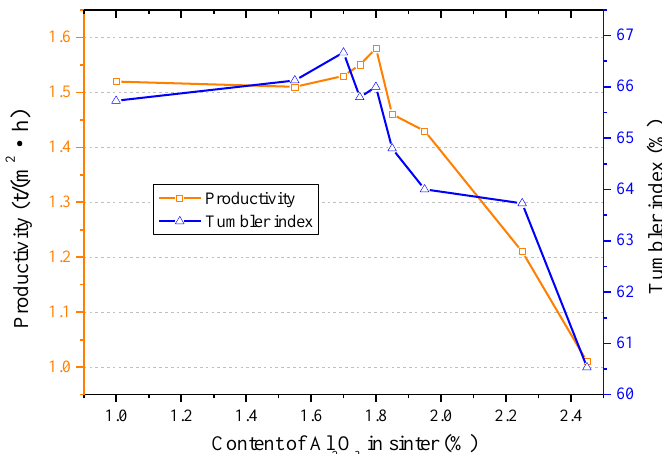
Figure 3. Influence of Al 2 O 3 content on productivity and tumbler index.